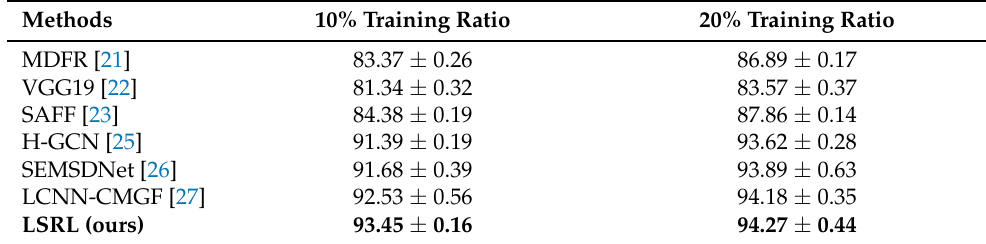
Table 2. The OA(%) of different methods on NWPU-RESISC45